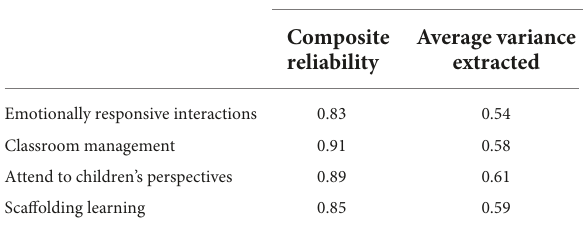
TABLE 4 Reliability of the four-dimensional